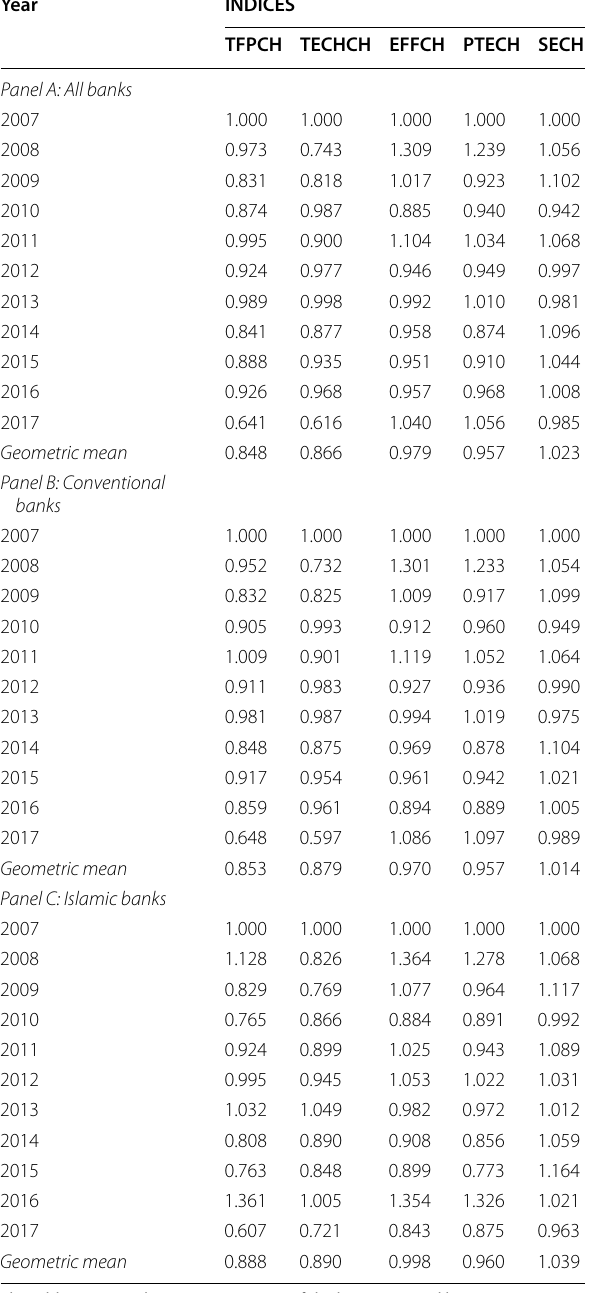
Table 5 Malmquist productivity index decompositions